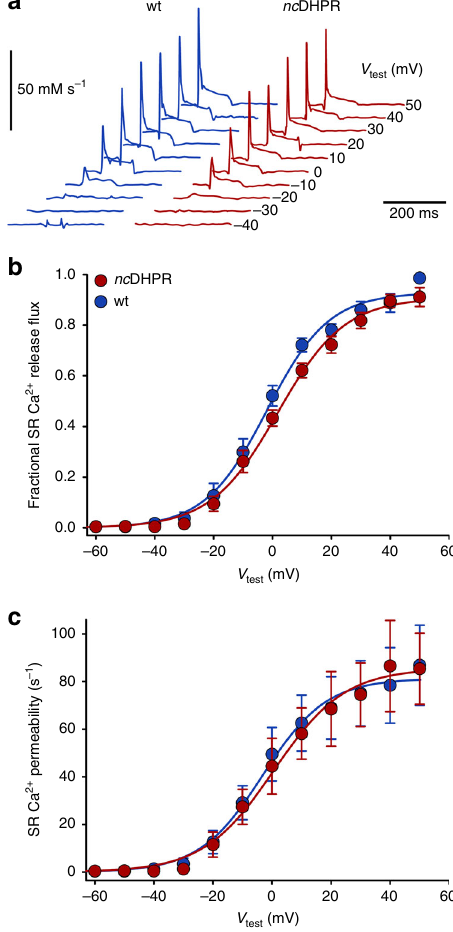
Fig. 2 Unaltered voltage dependence of SR Ca 2+ release in nc DHPR adult muscle fi bres. a Representative traces of Ca 2+ release fl ux signals determined from isolated adult toe fi bres ( musculus interosseus ) at 100-ms depolarizing voltage steps. The fl ux exhibits an early peak and a rapid decline to a lower level (plateau). Scale bars , 200 ms (horizontal), 50 mM s − 1 (vertical). b Voltage dependence of normalized peak Ca 2+ release fl ux is indistinguishable ( P > 0.05) between nc DHPR ( n = 12) and wt ( n = 10) adult muscle fi bres. c Ca 2+ release fl ux traces were converted to permeability with the assumption that the slow decline during the plateau phase results from SR depletion 60 . The calculated peak Ca 2+ release permeability as a function of voltage showed no signi fi cant difference ( P > 0.05) between nc DHPR and wt fi bres. Data are represented as mean ± s.e.m.; P determined by unpaired Student ’ s t